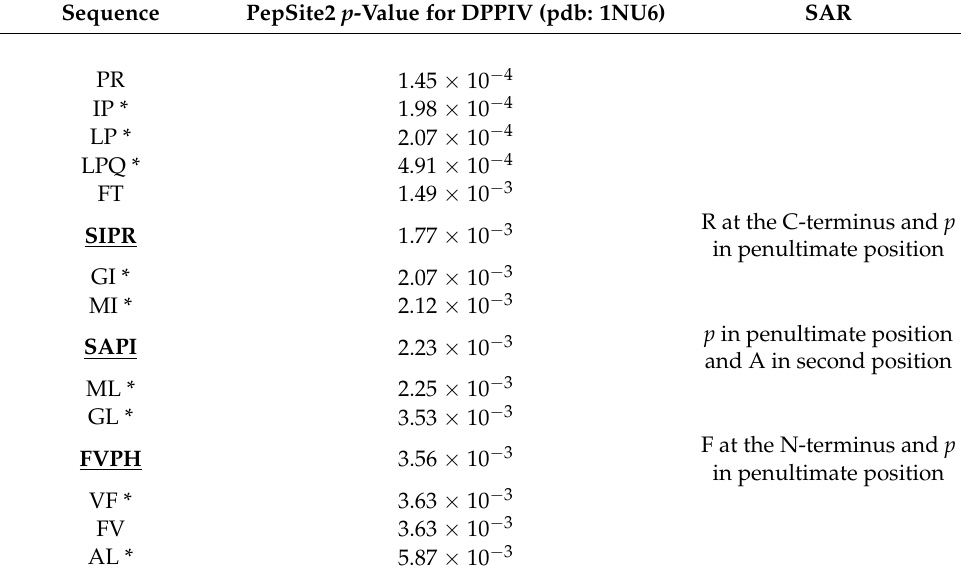
Table 2. Selection of potential DPP-IV-inhibitory peptides as a function of PepSite2 p -value and structure–activity relationship (SAR) modelling. Selected peptides were reported in bold and